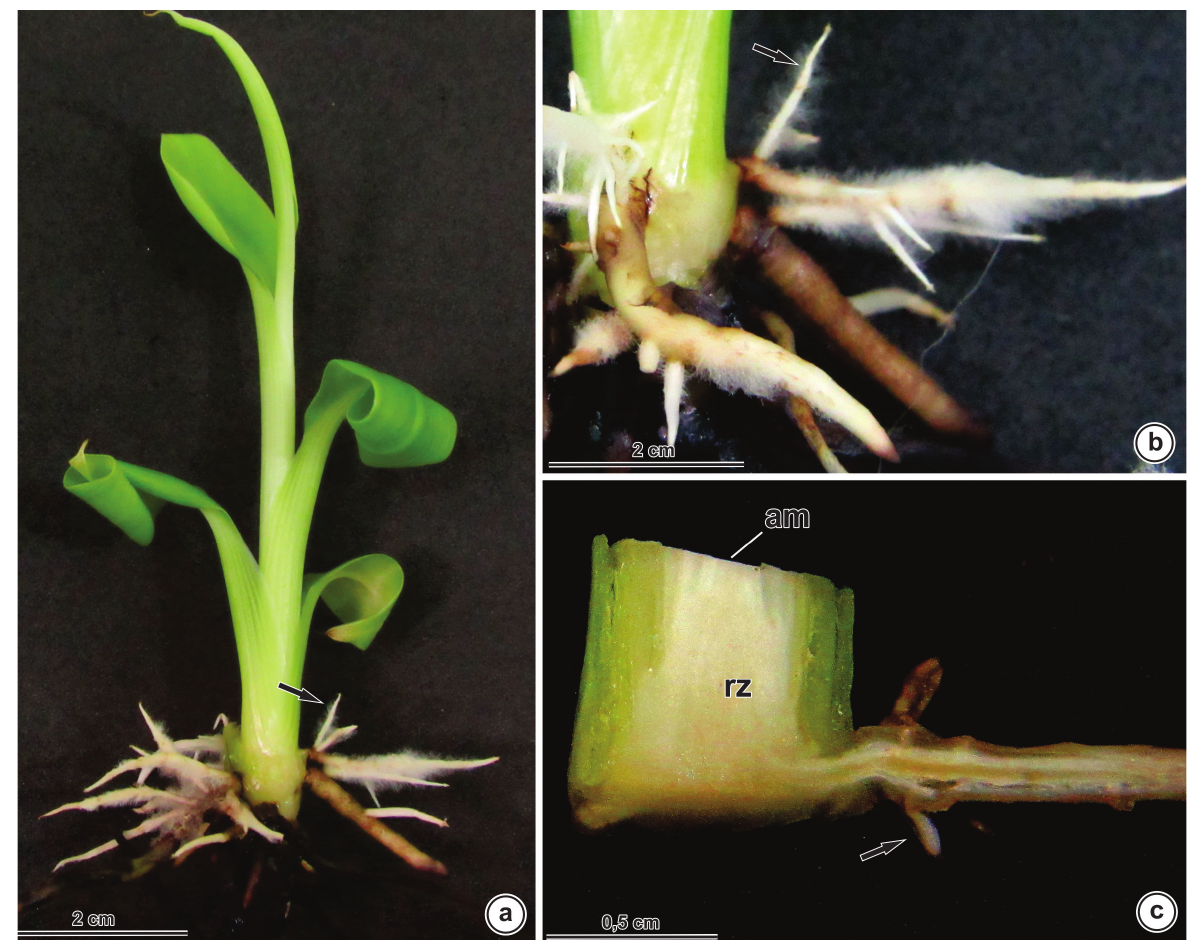
Figure 1- Morphology of the root system of a banana tree plantlet (cv. Prata-Anã) cultured in vitro in association with endophytic bacteria ( Bacillus sp. isolate EB-40) (a, b and c). am, apical meristem; rz,